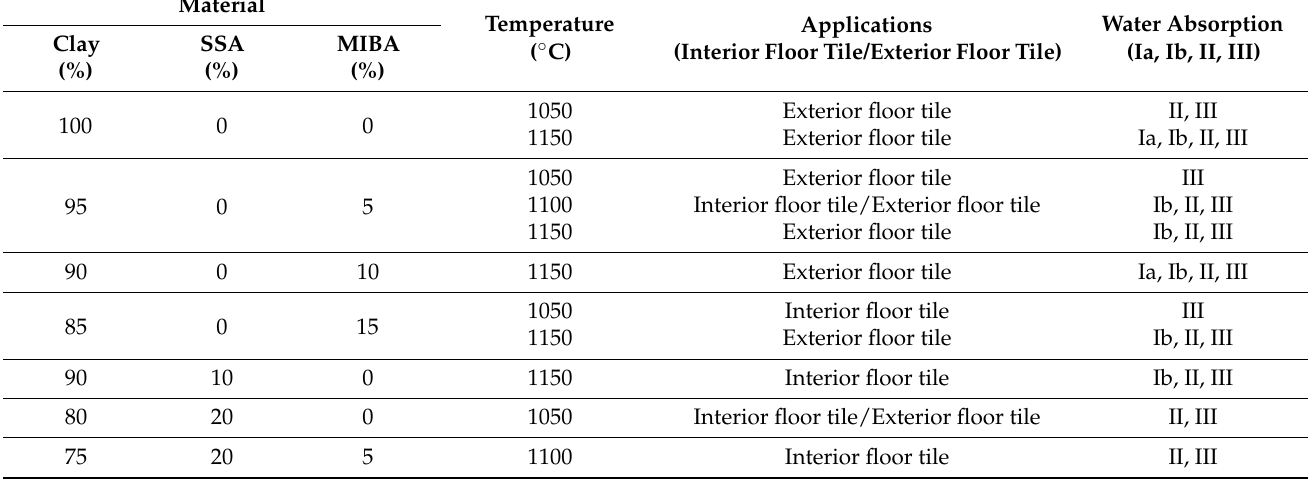
Table 6. Suggested application